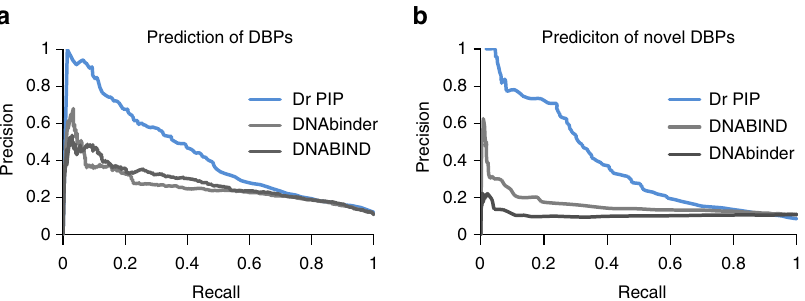
Figure 6 | Precision-recall curves (PRC) of the performances of Dr PIP compared to two publically available DNA binding protein prediction methods: DNAbinder 21 and DNABIND 20 , ( a ) on the non-redundant dataset of DBPs and non-DBPs that was used for Dr PIP construction, ( b ) on a set of novel DBPs, which are not members of DNA-binding superfamilies and do not have DNA binding motifs, patterns